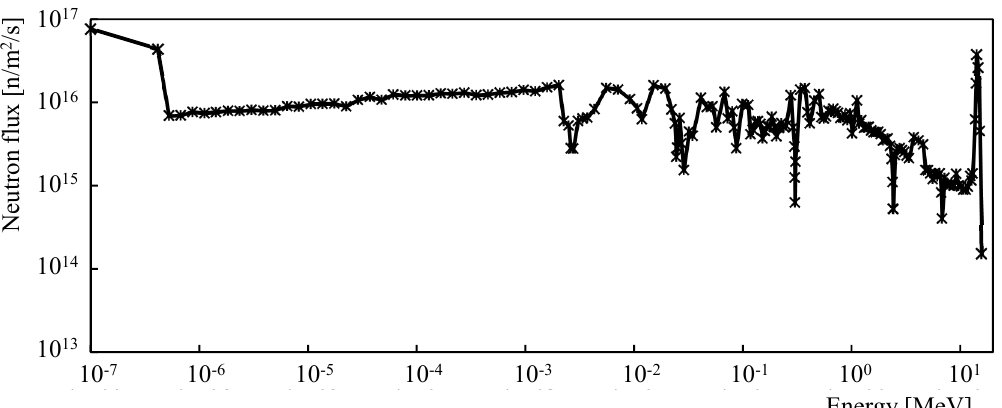
Figure 4. Neutron energy spectrum (175 energy groups) at the in-vessel divertor location of DEMO1 reactor used for the simulation [28,31].